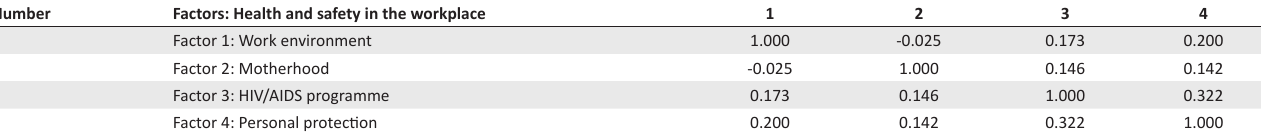
TABLE 6: Factor correlation matrix.